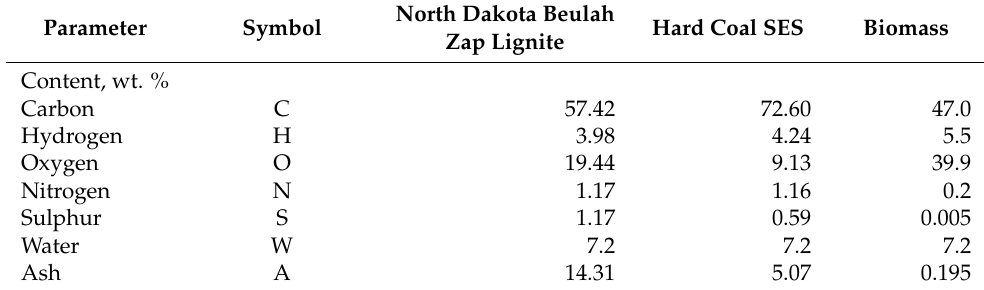
Table 9. Coal characteristic.